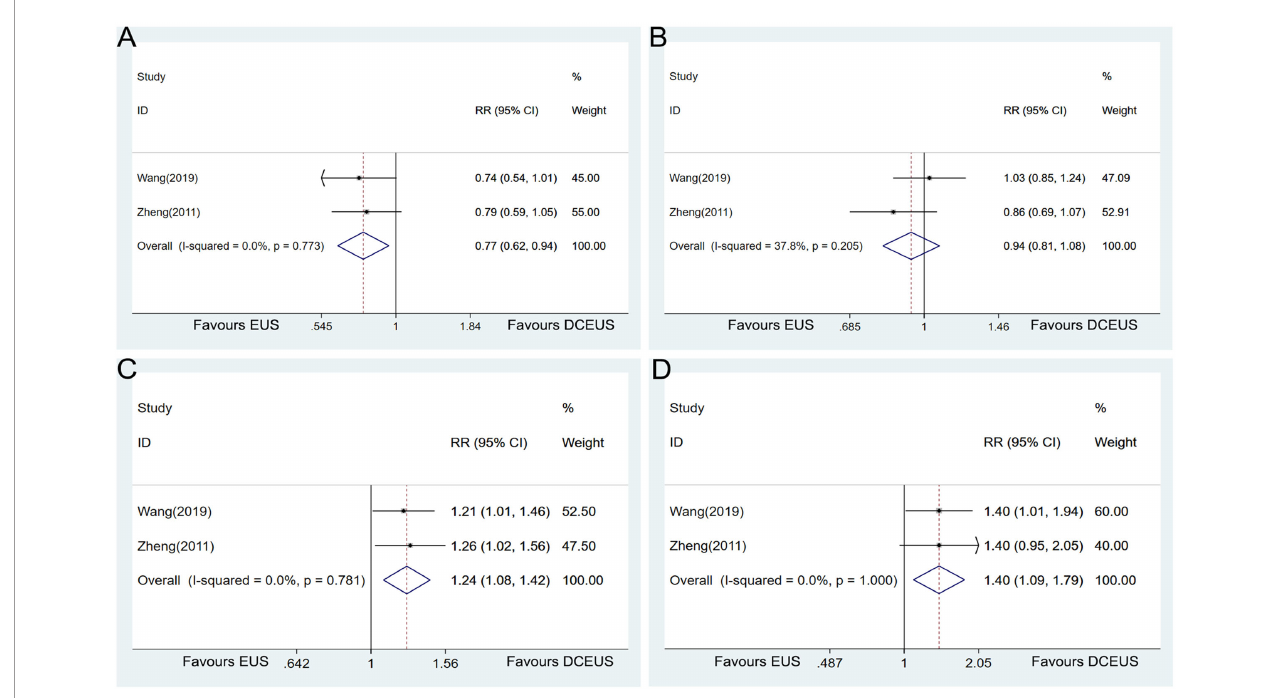
FIGURE 8 | Forest plot showing the pooled effects of the diagnostic performance of double contrast-enhanced ultrasonography compared with endoscopic ultrasound in diagnosing T1 (A) , T2 (B) , T3 (C) , and T4 (D) gastric